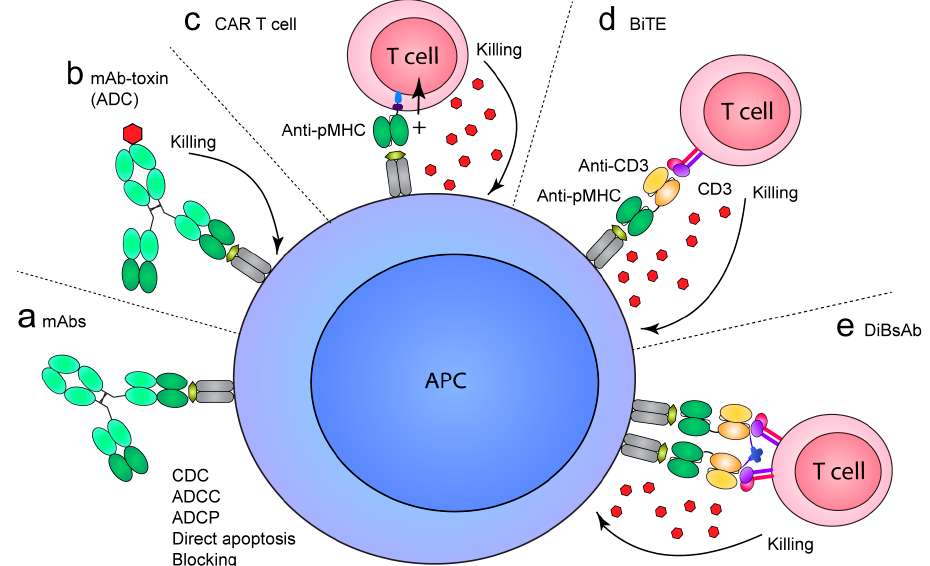
Figure 2. Potential modes of action of TCR-like mAbs in cancer, infection and autoimmunity. ( a ) TCR-like mAbs used in a classical antibody format, usually a full-length IgG, where binding to pMHC blocks T-cell accessibility (autoimmunity) or induces direct apoptosis. Alternatively, Fc-mediated effector functions, such as complement-dependent cytoxicity (CDC), antibody-dependent cellular cytotoxicity (ADCC) or antibody-dependent cellular phagocytosis (ADCP), can lead to targeted destruction of the peptide-presenting cell. ( b ) Targeted delivery of toxic payloads by antibody–drug conjugates (ADCs), where effector molecules, such as cytokines, toxins or radioactive substances, are coupled to an antibody format. Internalization of the complex leads to cell death. ( c–e ) Various strategies exist to redirect cytotoxic cells to a target cell. Binding triggers release of perforin and granzymes inducing apoptosis of the target cell in a co-receptor-independent manner. ( c ) Chimeric antigen receptor (CAR) T cells are redirected to peptide-presenting cells via the scFv fragment derived from a TCR-like mAb. ( d , e ) Bispecific protein formats, such as ( d ) bispecific T-cell engagers (BiTEs) and ( e ) bivalent formats illustrated by the dimeric bispecific T-cell-engaging tandem scFv antibodies (DiBsAbs), indirectly recruit T cells by bridging CD3 on T cells and natural killer (NK) T cells and the peptide-presenting